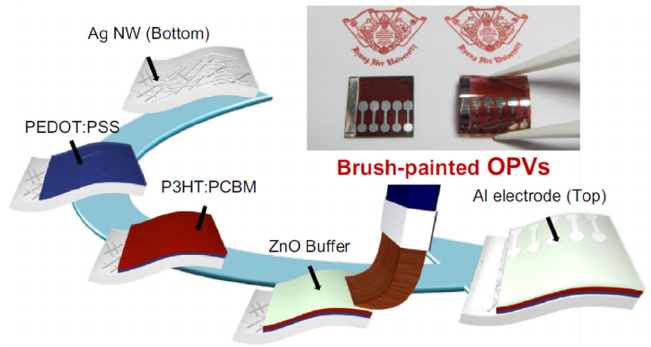
Figure 21. Schematics depicting a brush painting process of preparing brush ‐ painted flexible organic solar cells. The inset photo shows the flexibility of the brush ‐ painted flexible organic solar cells [79].